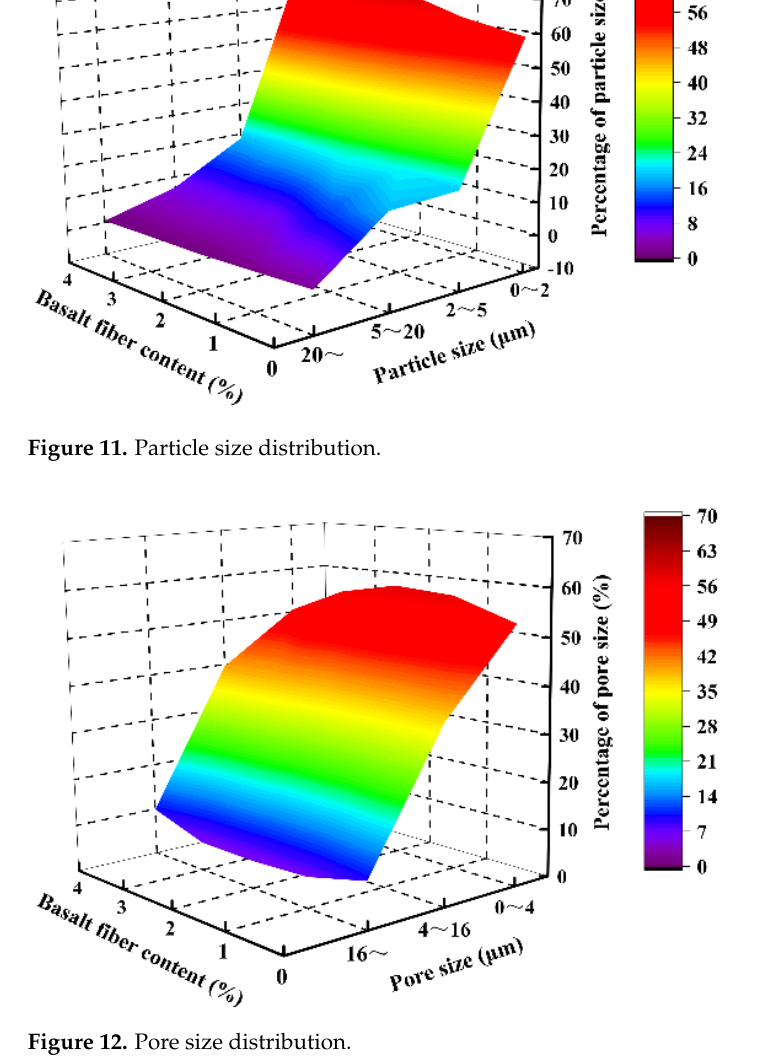
Figure 12. Pore size distribution.